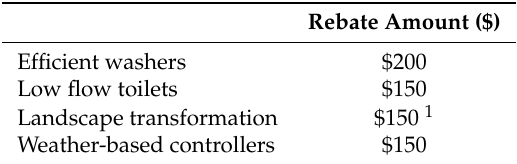
Table 7. Rebate amount perceived by